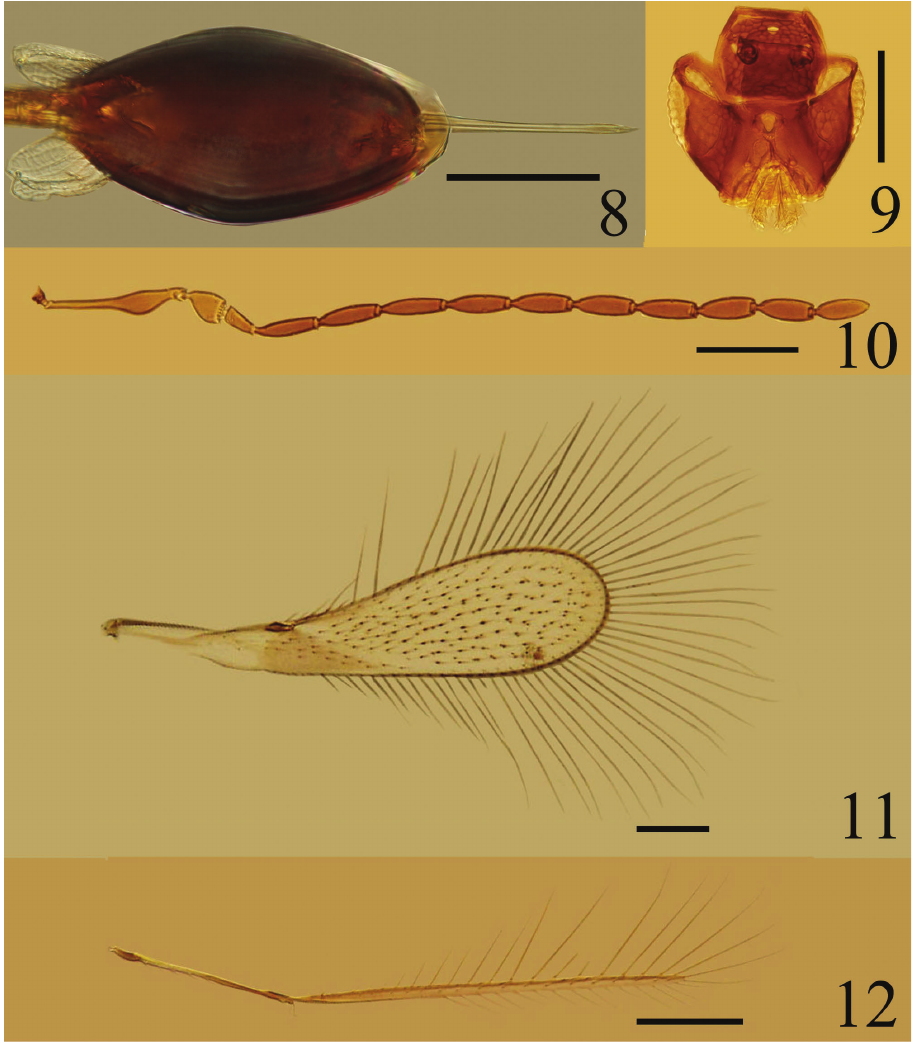
10 antenna 11 fore wing 12 hind wing. Scale bars=100